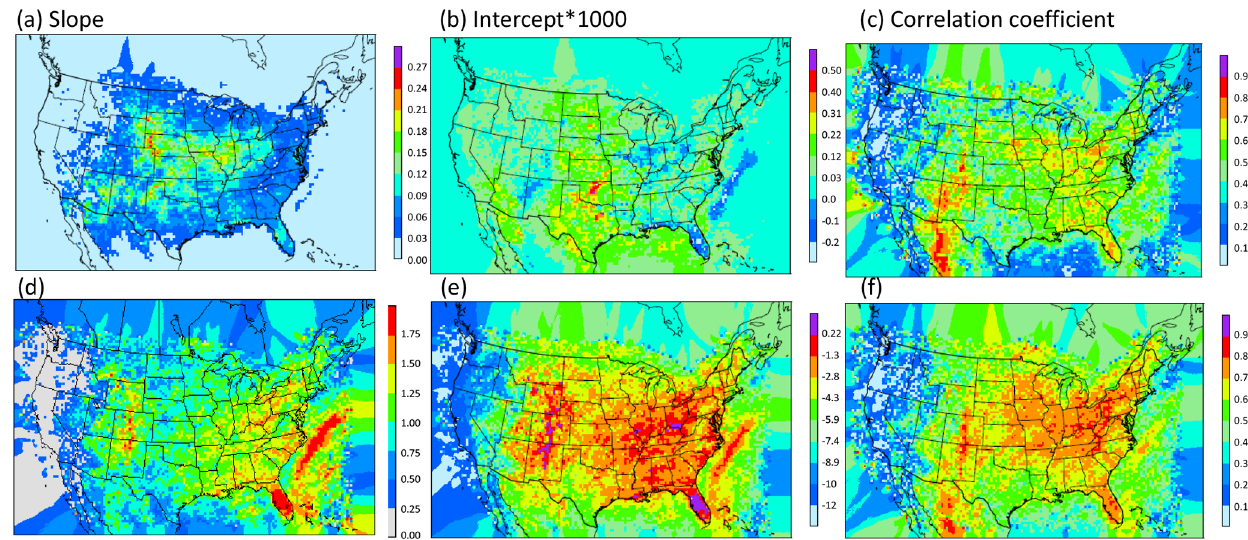
Figure 5. Parameters of linear (a–c) and logarithmic linear (d–f) regression parameters generated using all the data from 2002 to 2014. (a, d) slope, (b, e) intercept and (c, f) correlation coefficient.